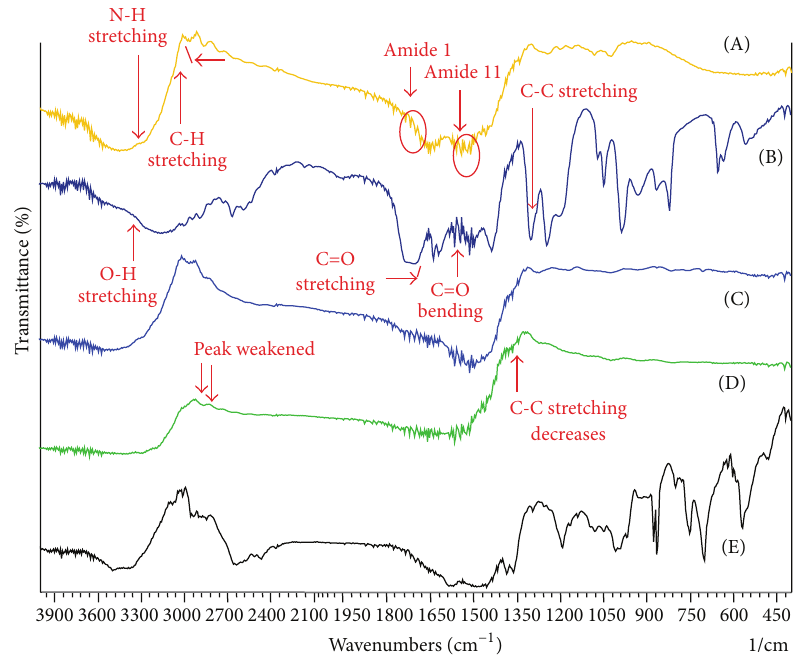
Figure 18: FTIR spectra of (A) pure gelatin, (B) acrylic acid, (C) unloaded AA/Gelatin hydrogel, (D) loaded AA/Gelatin hydrogel, and (E) pheniramine maleate.